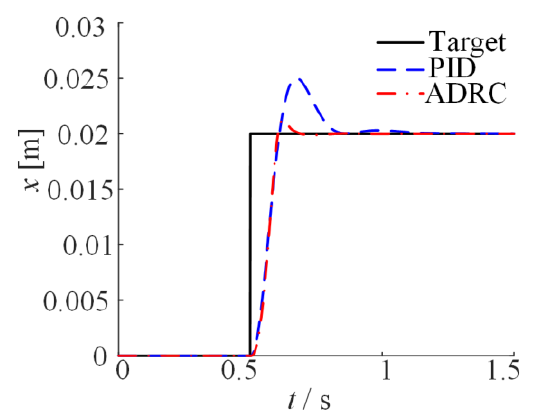
Figure 5. Simulated body vertical displacement of ADRC and PID controller under step signal.